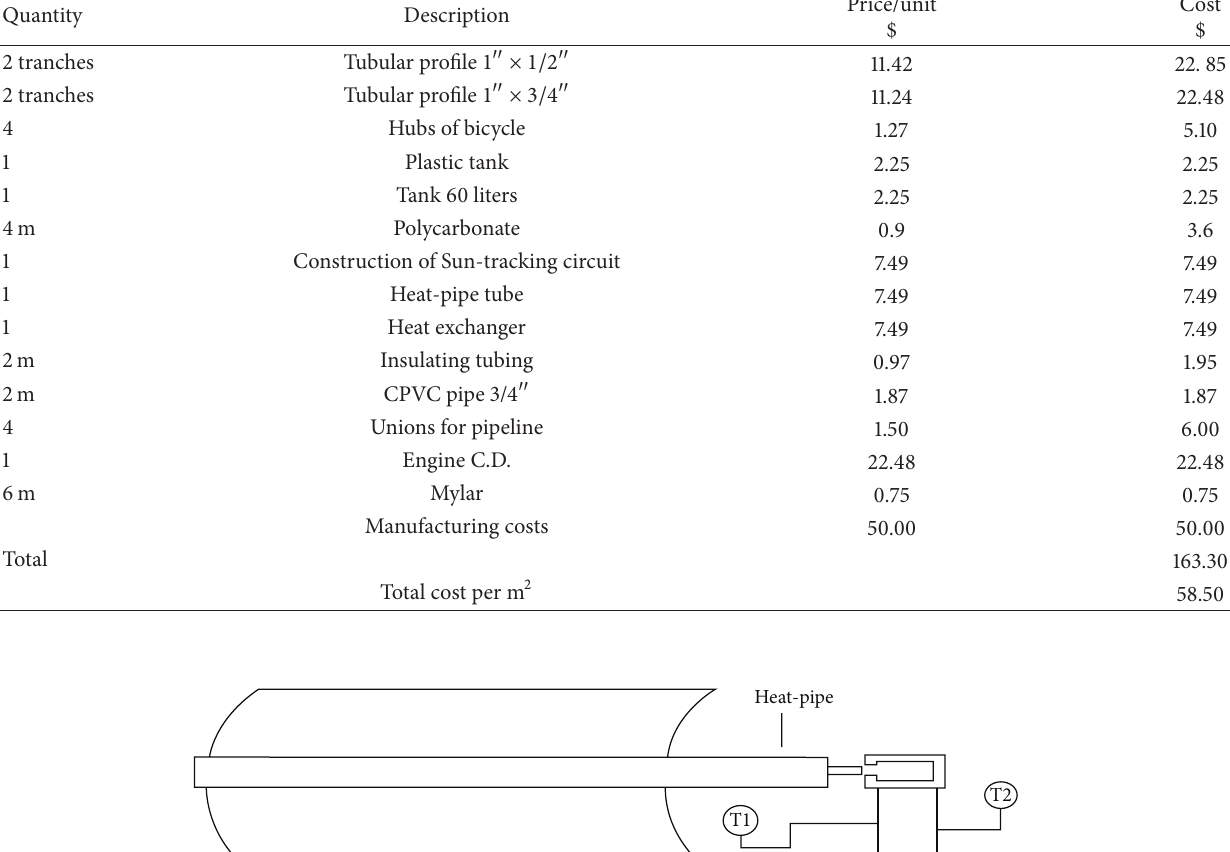
Table 2: Cost of the solar cylindrical collector.